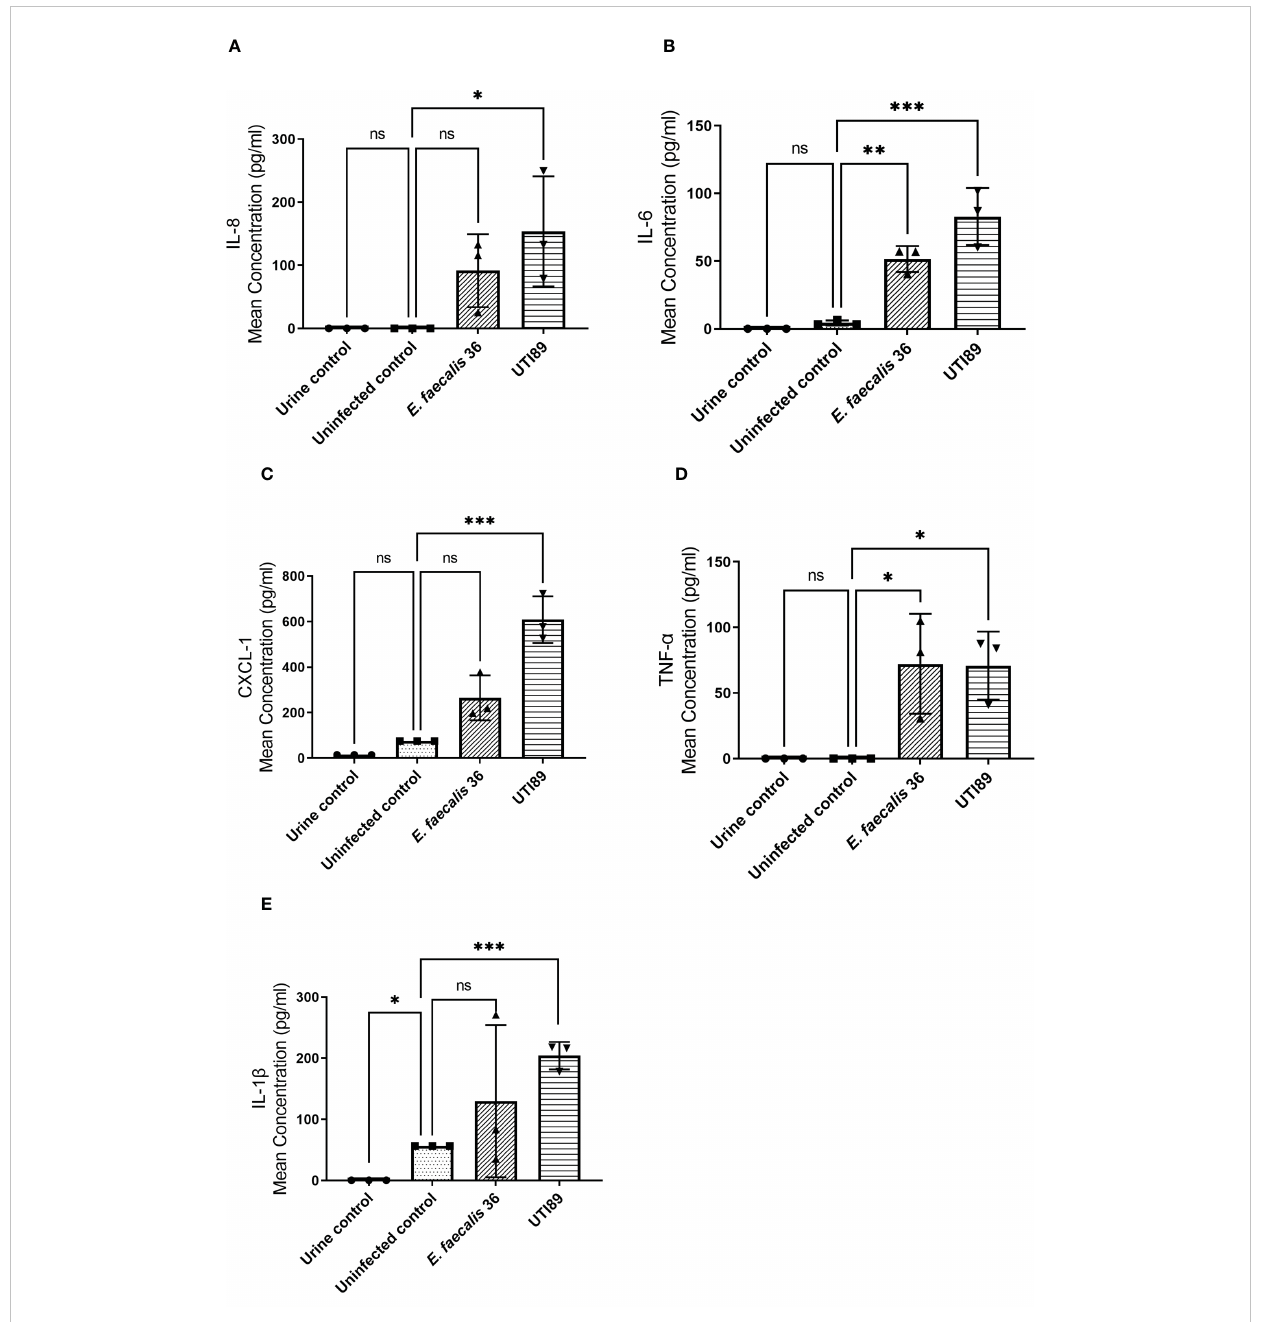
FIGURE 8 UTI89 and E. faecalis 36 trigger pro-in fl ammatory cytokine/chemokine responses. (A) IL-8; (B) IL-6; (C) CXCL-1; (D) TNF- a , and (E) IL-1 b release was measured by ELISA in response to UTI89 and E. faecalis 36 strains (MOI 10) at 24h p.i. Data represent mean ± SD, n=3 biologically independent experiments. *** p < 0.001, ** p < 0.01, * p < 0.05, ns ≥ 0.05 calculated by two-way ANOVA followed by Dunnett ’ s multiple comparisons